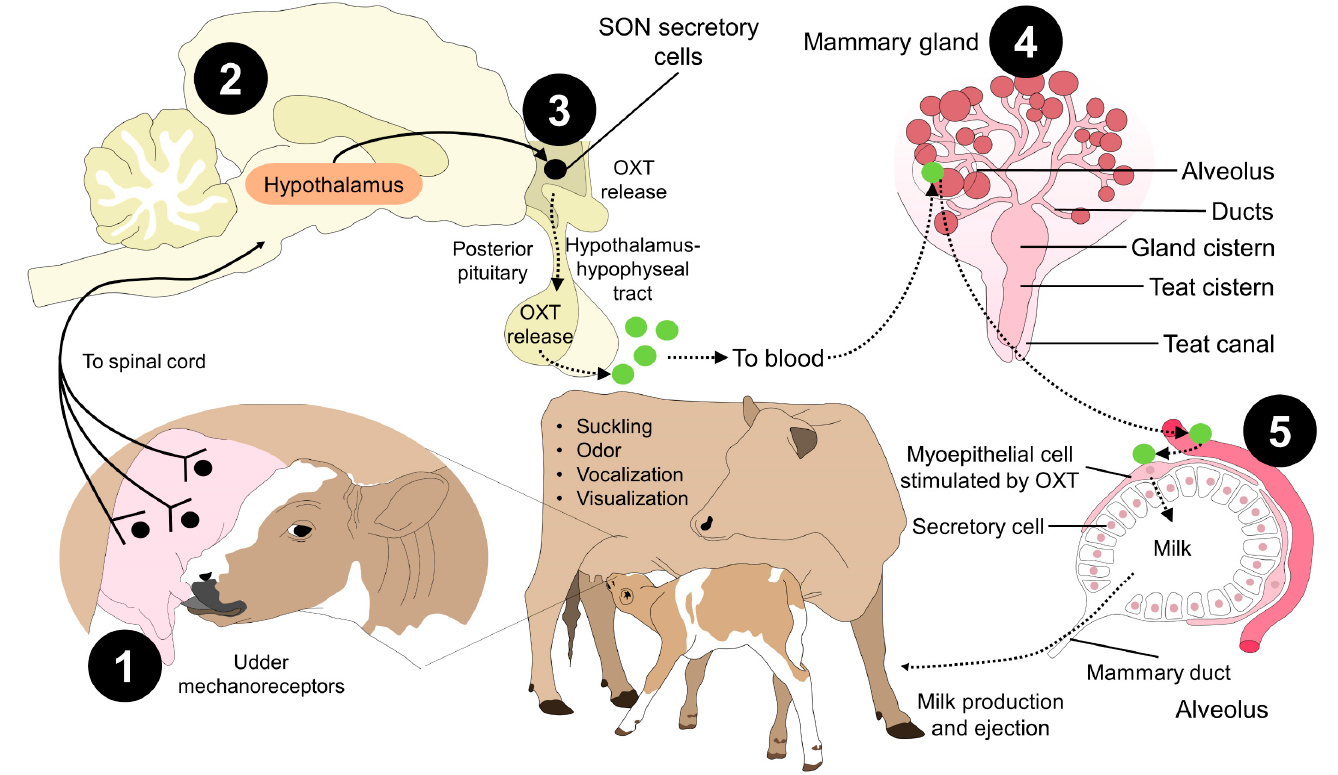
Figure 4. Neurophysiology of milk ejection and oxytocin influence. Milk yield and ejection can be divided into five stages. 1. Environmental stimulus, such as suckling from the calf, activates udder mechanoreceptors in the teat. 2. Through nervous tracts, the sensory signal reaches the hypothalamus. 3. The SON secretory cells are activated to release OXT. 4. When OXT reaches the bloodstream, it acts on the myoepithelial cells of the alveolus, causing the contraction and secretion of milk by the secretory cells (5). This physiological path and the aforementioned stimulus from the offspring are one of the reasons why manual or mechanical stimulation of the udder is important in dairy systems and can depend on OXT administration, regardless of its controversial e ff ects. OXT: oxytocin; SON: supraoptic nucleus.